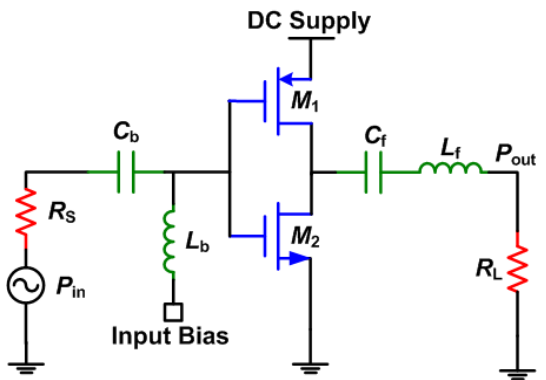
Figure 11. Basic schematic of a class-D power